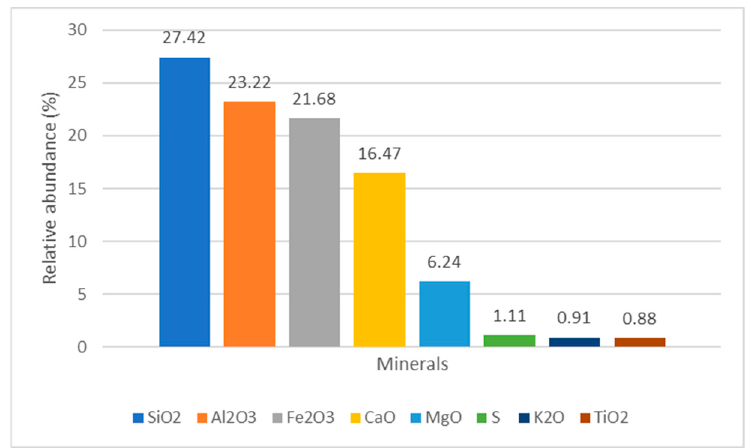
Figure 3. Relative abundance of dominant minerals in the CFA